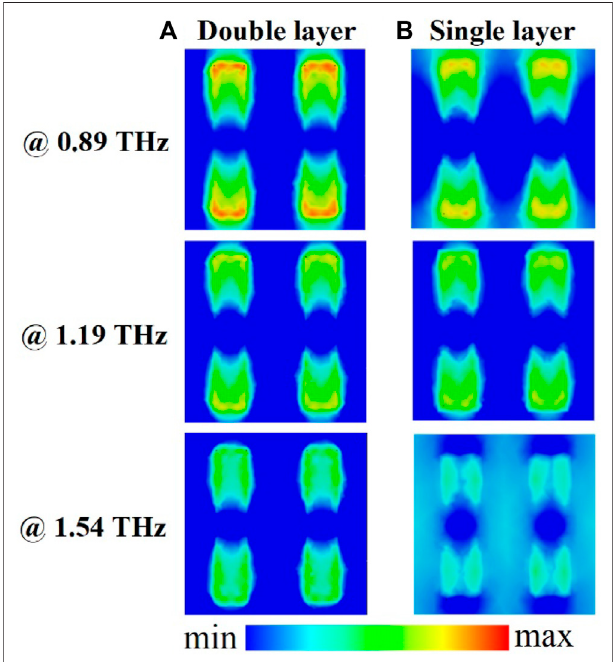
FIGURE4| Magnetic fi elddistributionsof (A) doublelayerand (B) single layer for three transmission peaks at 0.89, 1.19, and 1.54 THz, respectively.